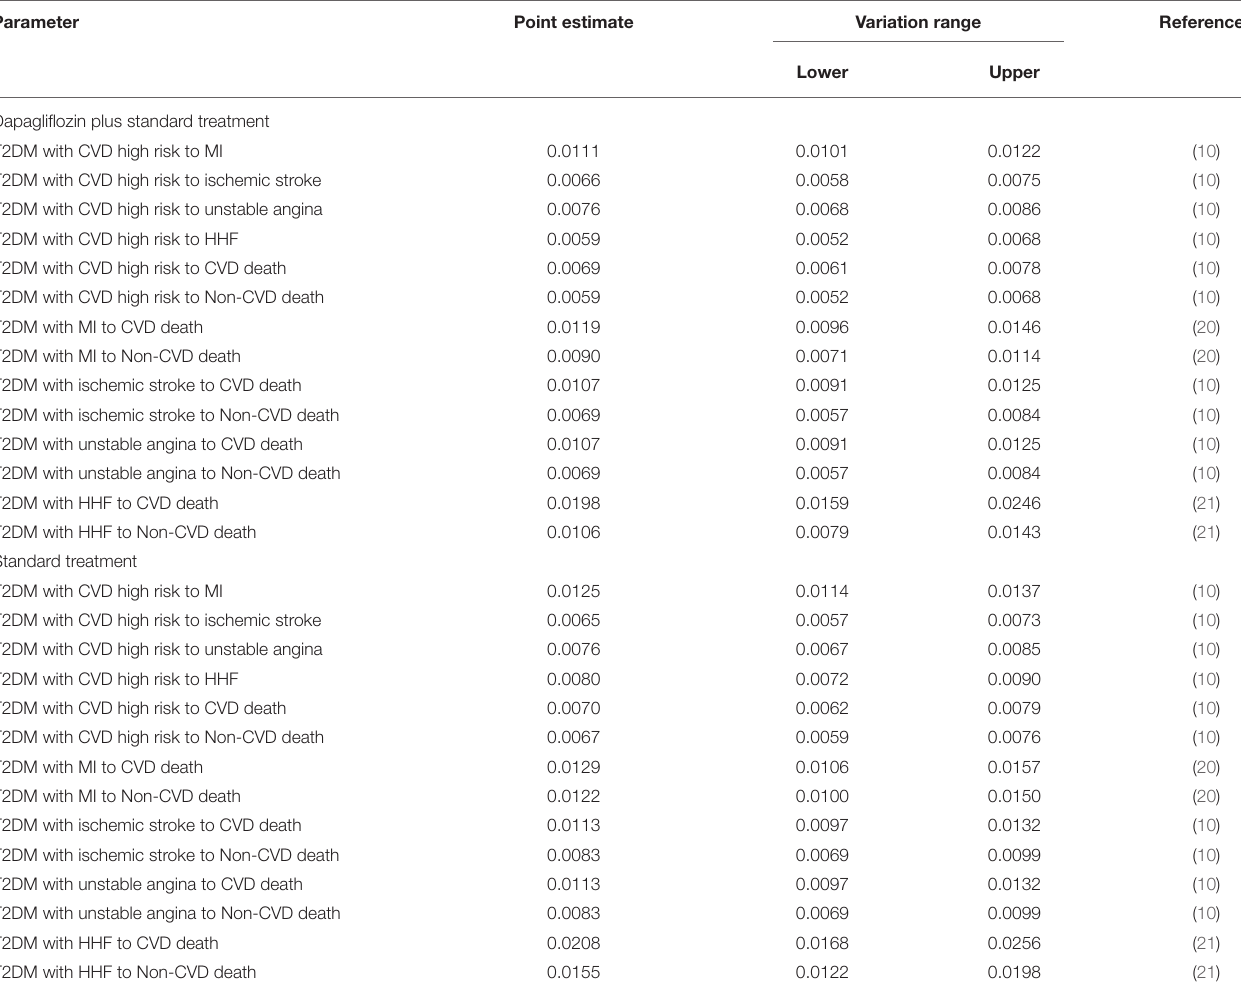
TABLE 1 | Transition